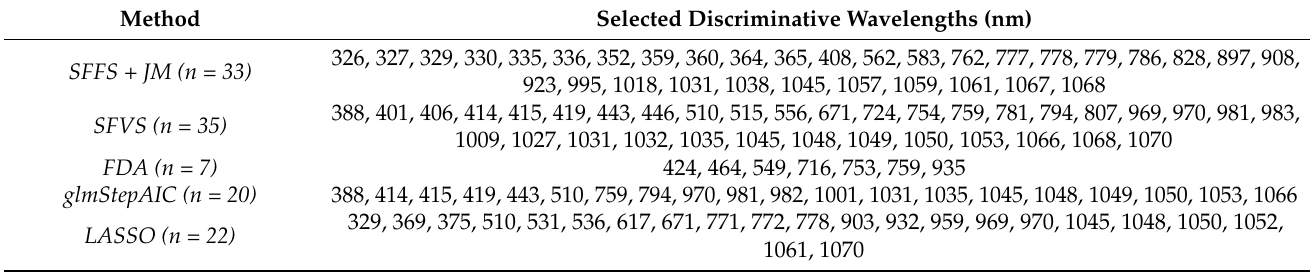
Figure 2. Representation of the spectra collected ( a ), and after its filtering ( b ) using the MSC log algorithm. Table 1. Selected discriminative wavelengths for model